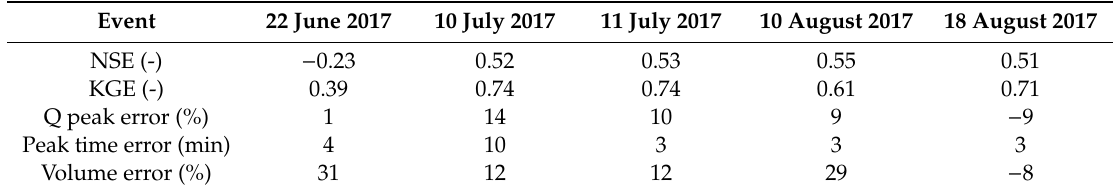
Table 4. Calibration skill-scores and